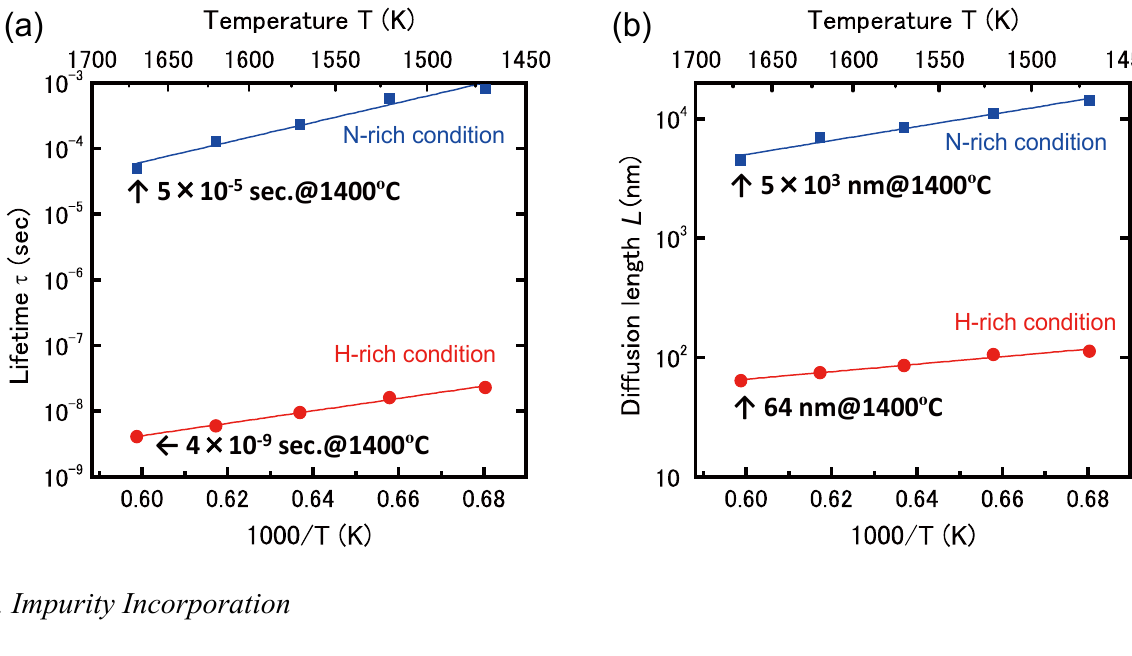
Figure 34. Calculated ( a ) life time, τ , and ( b ) diffusion length, L AlN(0001) surface as a function of reciprocal temperature at an Al pressure of 1 × 10 − 3 Torr as obtained by kinetic Monte Carlo